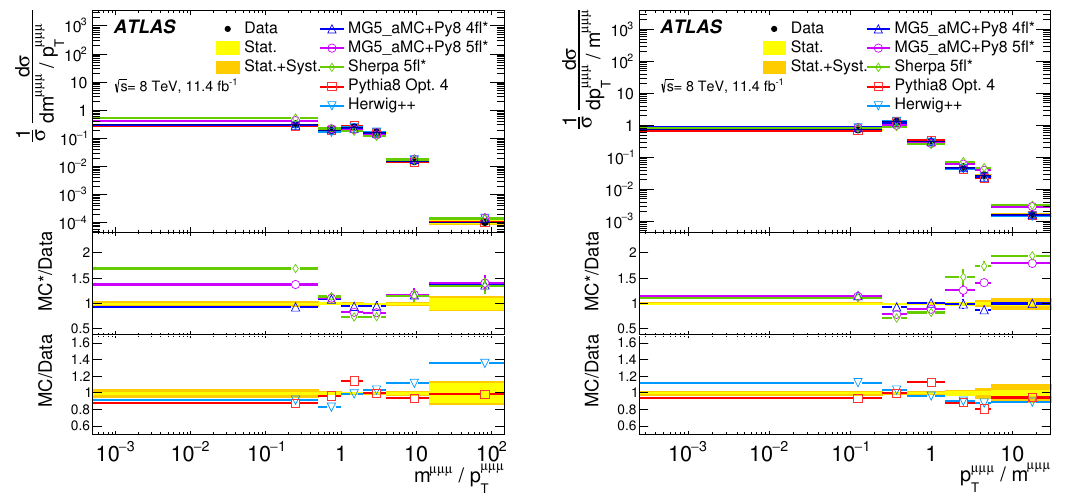
Figure 9 . Measured normalised di(cid:11)erential cross sections as a function of m=p T and p T =m . Comparisons are made with predictions of Pythia8 and Herwig++ . Mad- Graph5 aMC@NLO + Pythia8 and Sherpa predictions are also compared having been corrected from the two- b -hadron production to the three-muon (cid:12)nal state via transfer functions (indicated with *). The Pythia8 \Opt. 4" gluon splitting parameter settings are described in table 1. The ra- tio to data of the MadGraph5 aMC@NLO + Pythia8 and Sherpa (middle pane), and Pythia8 and Herwig++ (bottom pane) are also